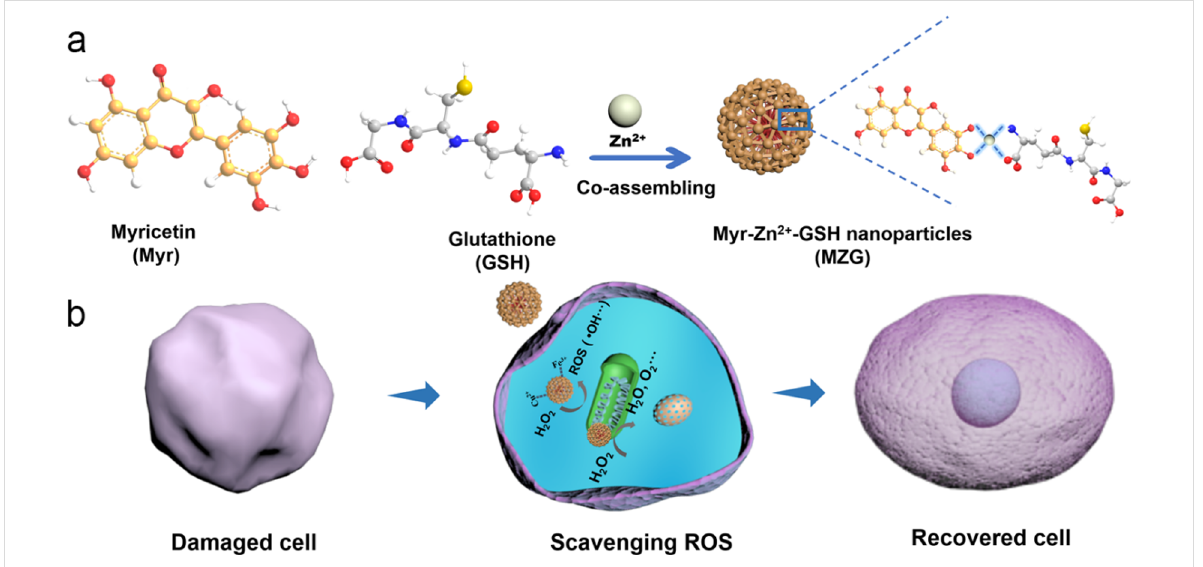
Figure 1: Schematic illustration of preparing MZG nanoparticles (a) and (b) antioxidation mechanism in cells. MZG nanoparticles afford the antioxi- dant activity for maintaining redox homeostasis in cells.